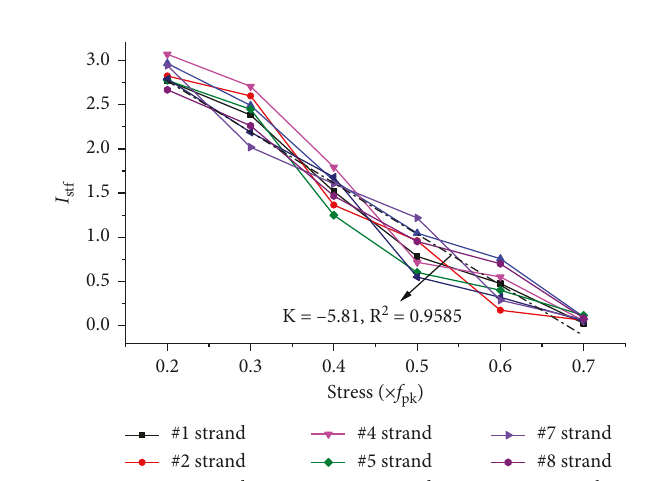
Figure 10: Measured guided waves.